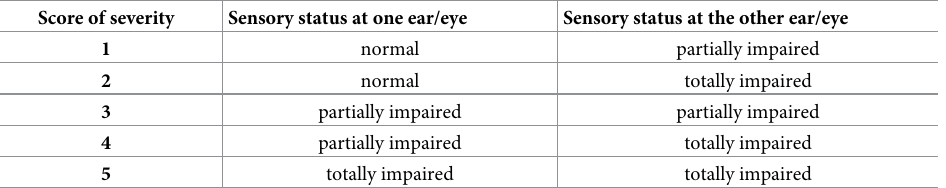
Table 4. Score of severity of hearing and vision impairments determined from owners’ responses to the sensory status of their dog at each